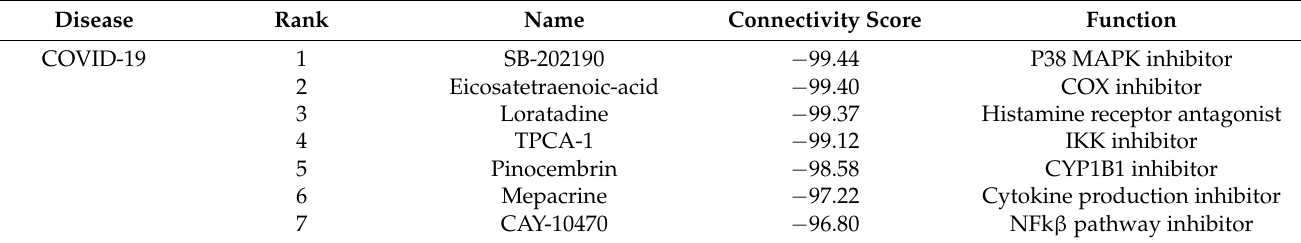
Table 3. Candidate drugs as identified using Connectivity Map through